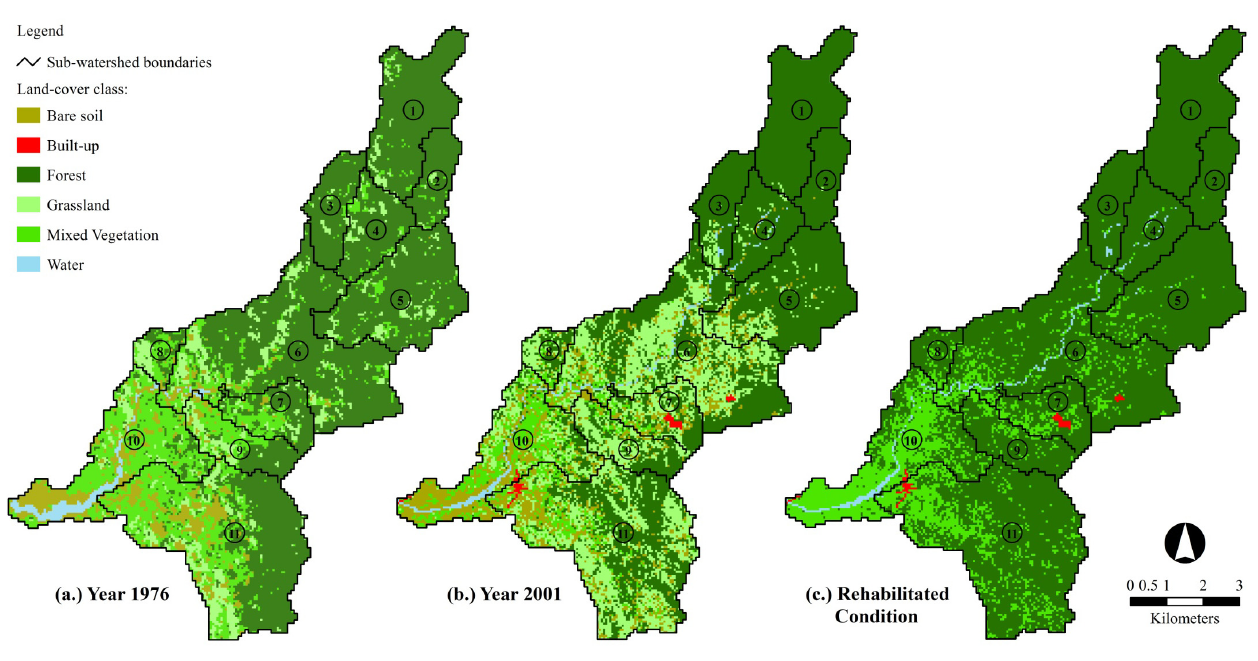
Figure 2. The land-cover maps derived from the analysis of the Landsat MSS and ETM+ images through Maximum Likelihood classification. (a) 1976 land-cover map; (b) 2001 land-cover map; and (c) rehabilitated land-cover map. In (c), the watershed is in a condition where barren areas and grasslands detected from the 2001 Landsat ETM+ image as consequences of anthropogenic disturbances, were rehabilitated through their conversion to mixed vegetation and reforestation,